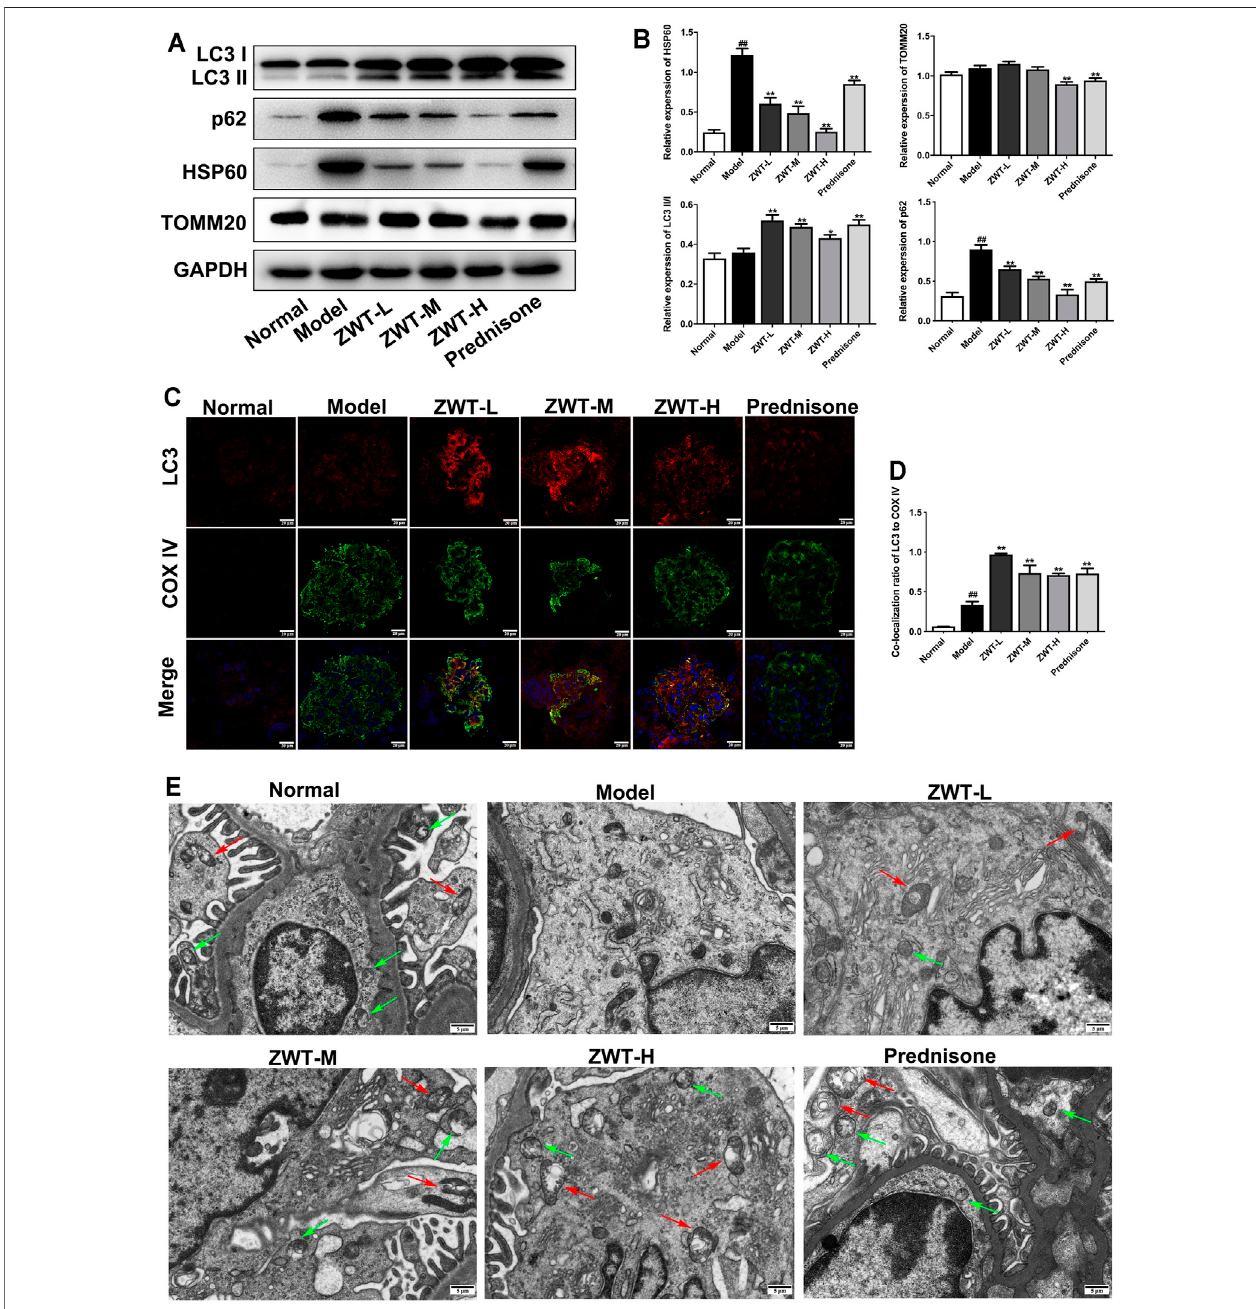
FIGURE 4 | ZWT induced mitophagy in CGN model rats. (A, B) The protein blots and quantitative analysis of LC3 II/I, p62, heat shock protein 60 (HSP60), and translocase of outer mitochondrial membrane 20 (TOMM20). The obtained values of HSP60, TOMM20, and p62 were normalized to GAPDH; LC3 II values were normalized to LC3 I. (C, D) The representative images and quantitative analysis of LC3 and COX IV colocalization ( × 400 magni fi cation; scale bar (cid:2) 20 μ m). (E) Representative images of mitochondrial autophagosomes by Transmission electron microscopy ( × 5,000 magni fi cation; scale bar (cid:2) 5 μ m). Red arrows indicated mitochondrialautophagosome.Greenarrowsindicateautophagosome.Dataarerepresentedasmean ± SD( n (cid:2) 3). ## p < 0.01versusnormalgroup,* p < 0.05and** p < 0.01 versus model group. ZWT alleviated mitochondrial dysfunction in